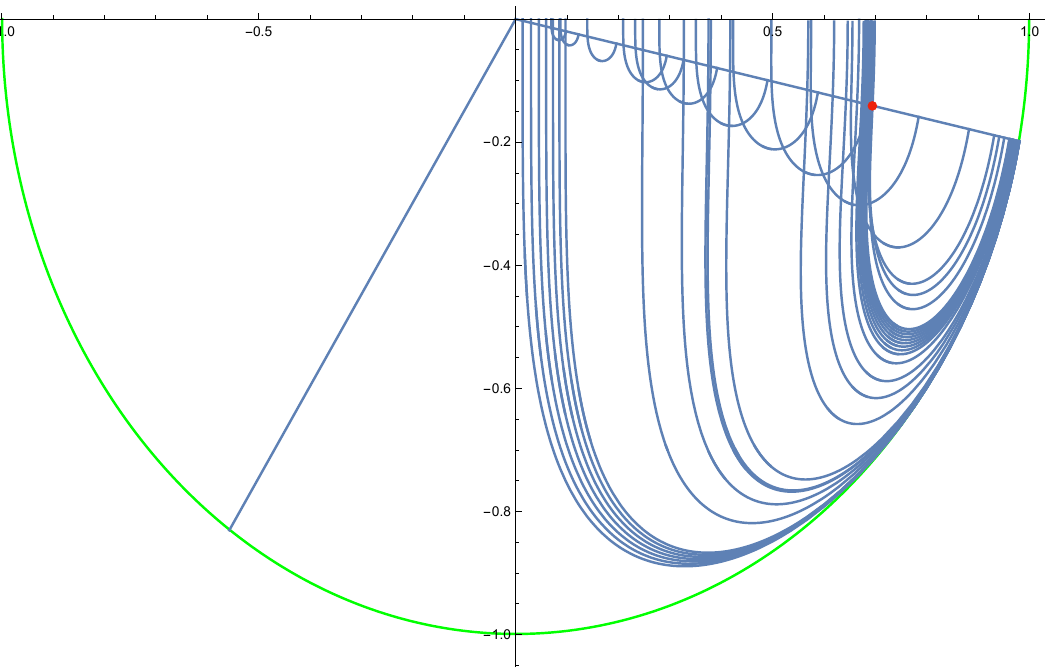
Figure 3. A collection of curves that start and end on a single brane. The Neumann ends are shown as ending on the brane, the Dirichlet ends are extended to the boundary of the AdS geometry. The red dot is the Dirichlet